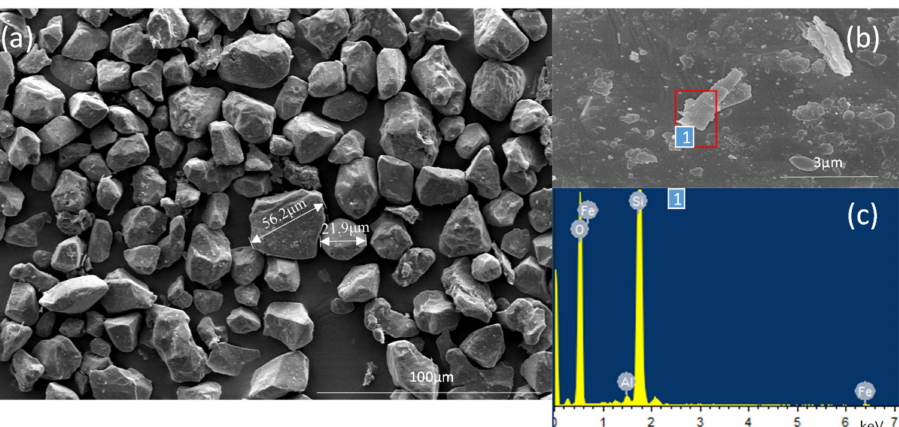
Figure 2. ( a ) SEM image of NPQ, ( b ) SEM image of impurity adhering on quartz surface, ( c ) EDS of